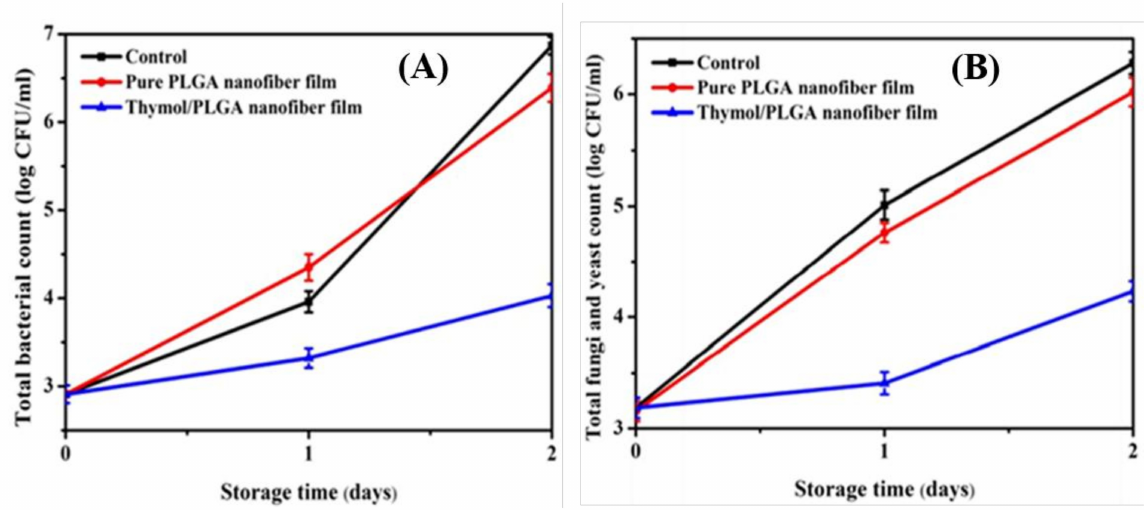
Figure 8. Impact of separate packages on ( A ) the total number of bacteria and ( B ) the total number of fungi and yeast in the strawberries deposited for 3 days at 25 ± 1 ◦ C. Adapted from [125] with copyrights permission from the American Chemical